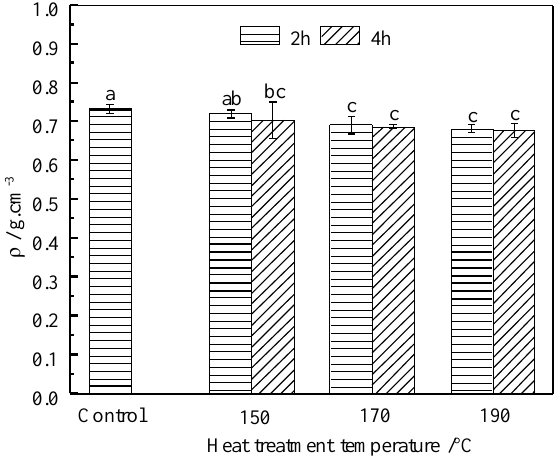
Figure 3. Density of the control and HT wood. Bars with different letters indicate significant differ- ences ( p < 0.05) according to Duncan’s multiple range tests.